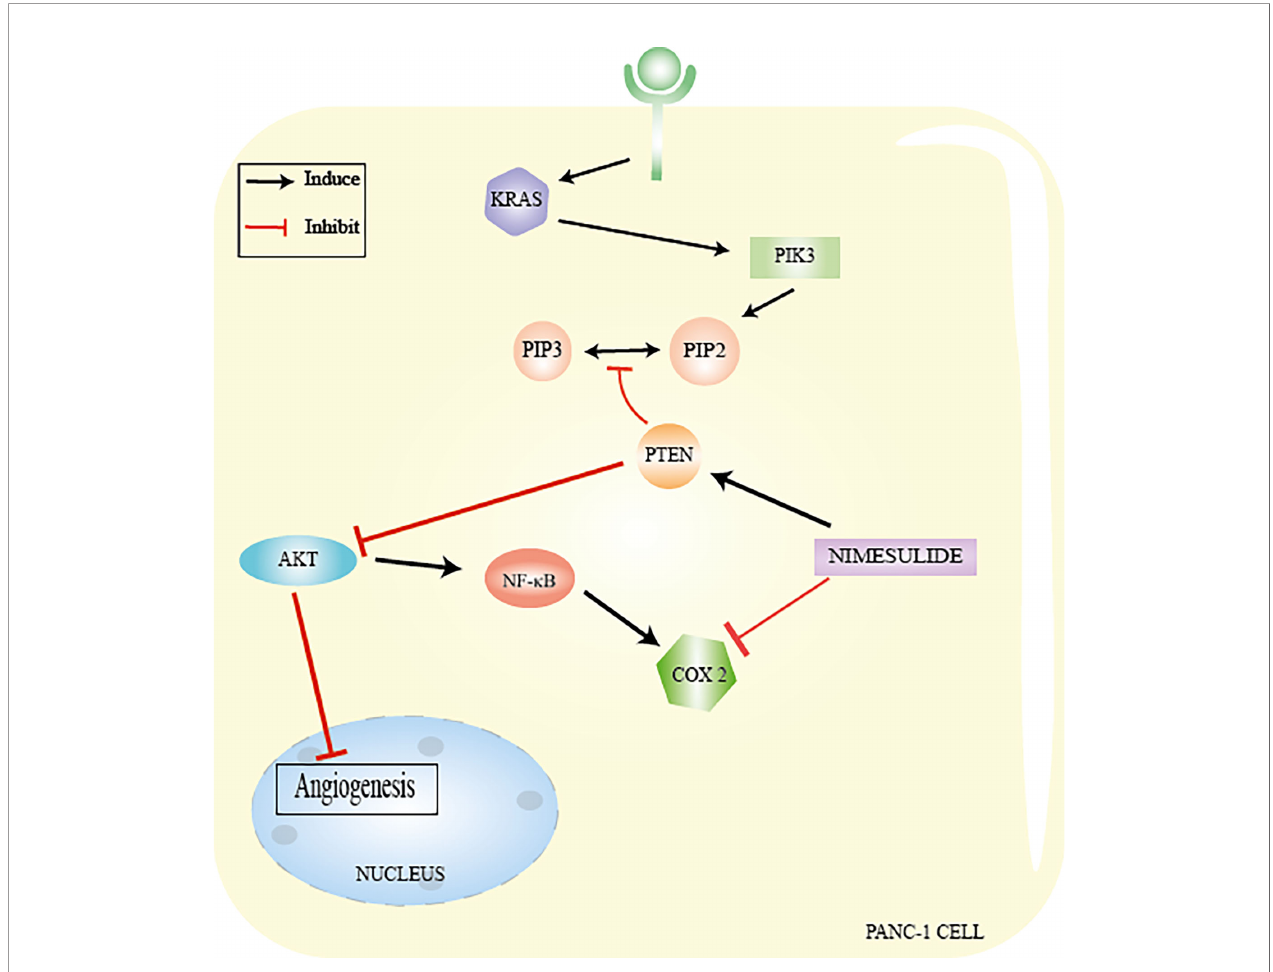
FIGURE 5 | Nimesulide in PANC − 1 cells. Nimesulide inhibits proliferation and promotes apoptosis of PANC-1 cells (cell line isolated from a ductal pancreatic adenocarcinoma) via increased expression of PTEN. AKT regulates a series of important effector proteins, such as NFkB, COX-2, VEGF, Bcl-2, and Bax. Nimesulide inhibits angiogenesis by inducing an increase in PTEN levels and leading to suppression of AKT by decreasing VEGF levels. PTEN reactivation appears to be related to a decreased expression of COX-2 and also acts by suppressing AKT and consequently inhibiting NF-kB, which decreases the expression of COX-2. From: